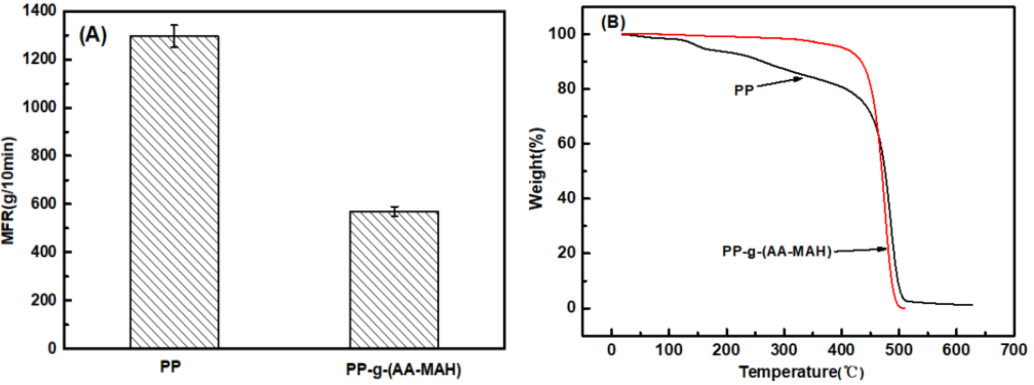
Figure 6. MFR ( A ) and TG ( B ) of PP and PP-g-(AA-MAH) fibers.